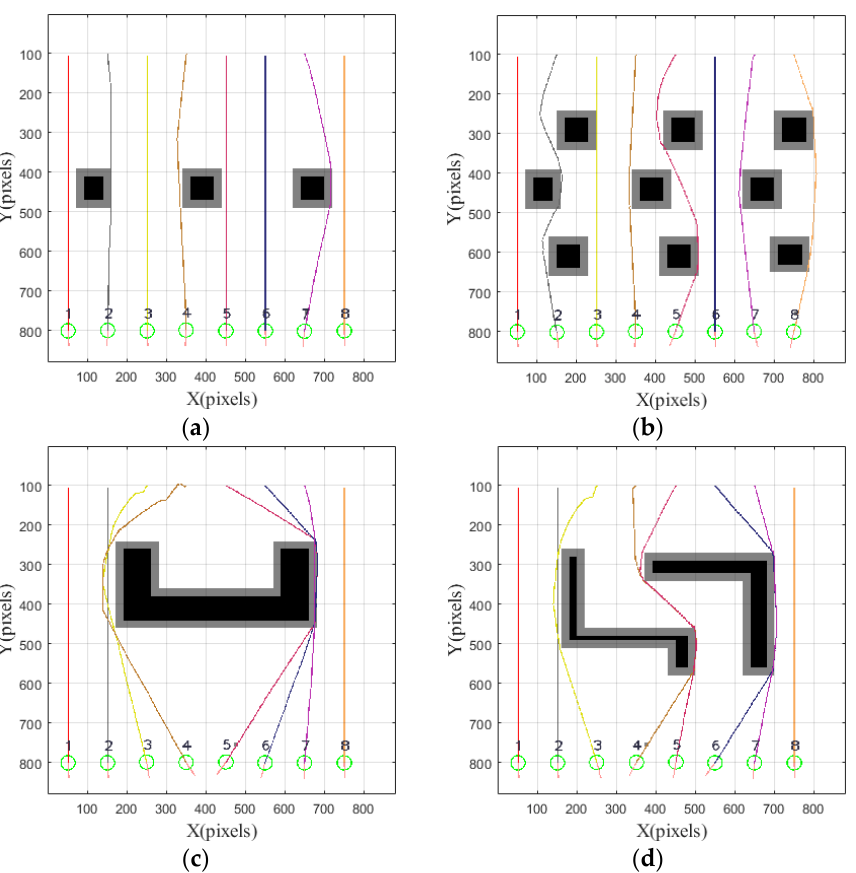
Figure 12. ( a ) A simple test with three obstacles, ( b ) nine obstacles interlaced test, ( c ) concave polygon obstacle test, and ( d ) passage-type obstacle